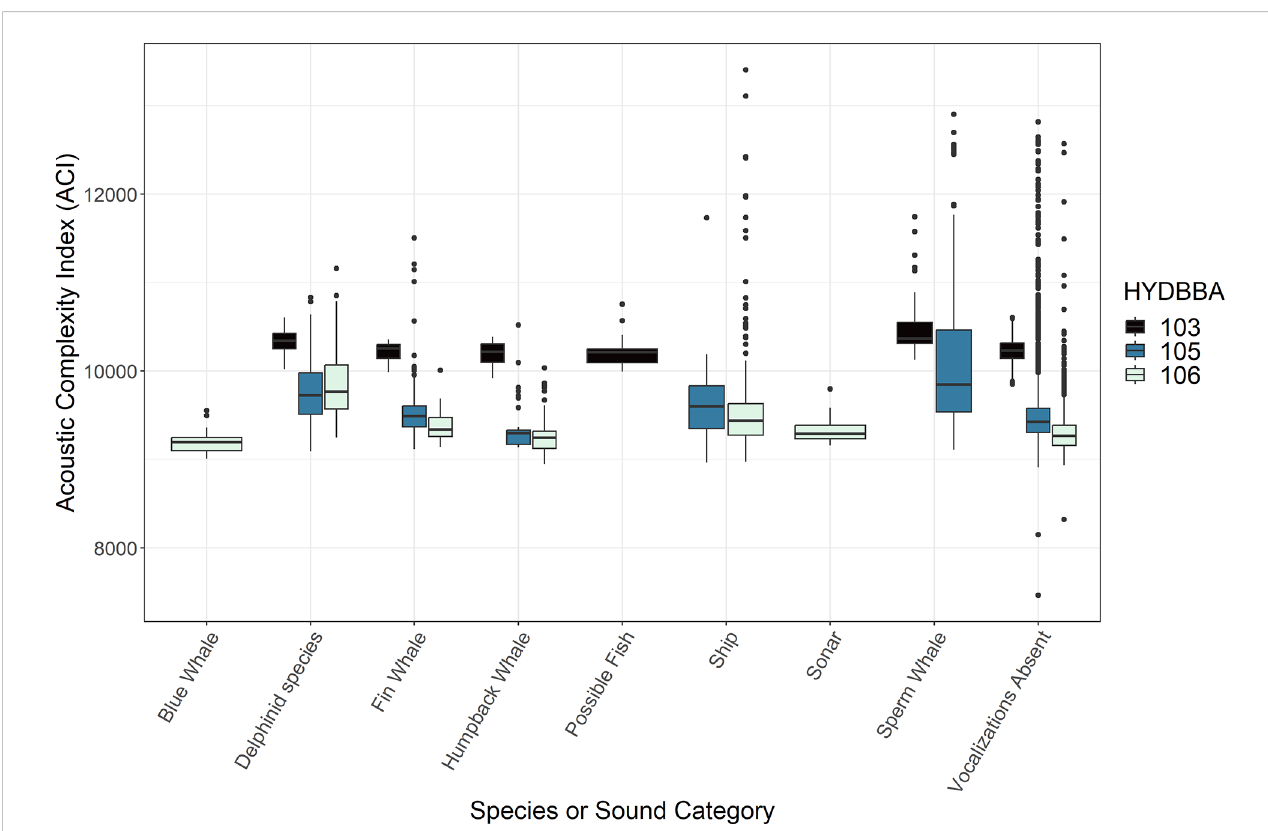
FIGURE 2 Box plots representing measurements of Acoustic Complexity Index (ACI) associated with underwater sounds. Data are organized by recorders located on the shelf (106), the slope (105) and at the base of the slope (103). Marine mammal species and human-made sounds vary for each recorder resulting in some sound types with only one or two box plots. All recorders include a plot for data that contained no annotated sound (labeled ” Vocalizations Absent “